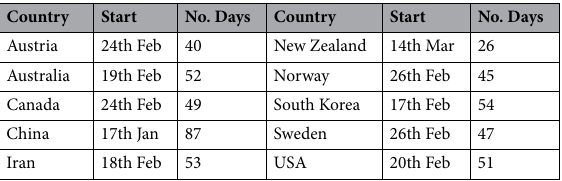
Table 3. Start date and number of observations of cases time